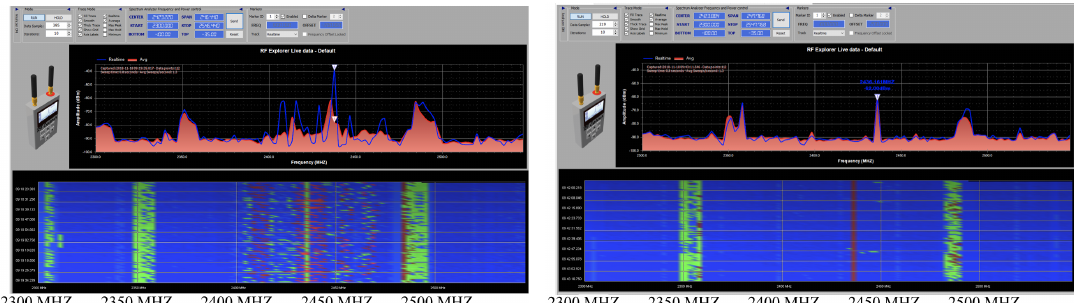
Figure 12. Radio environmental measurement near the building ( left ) and in the park ( right ).